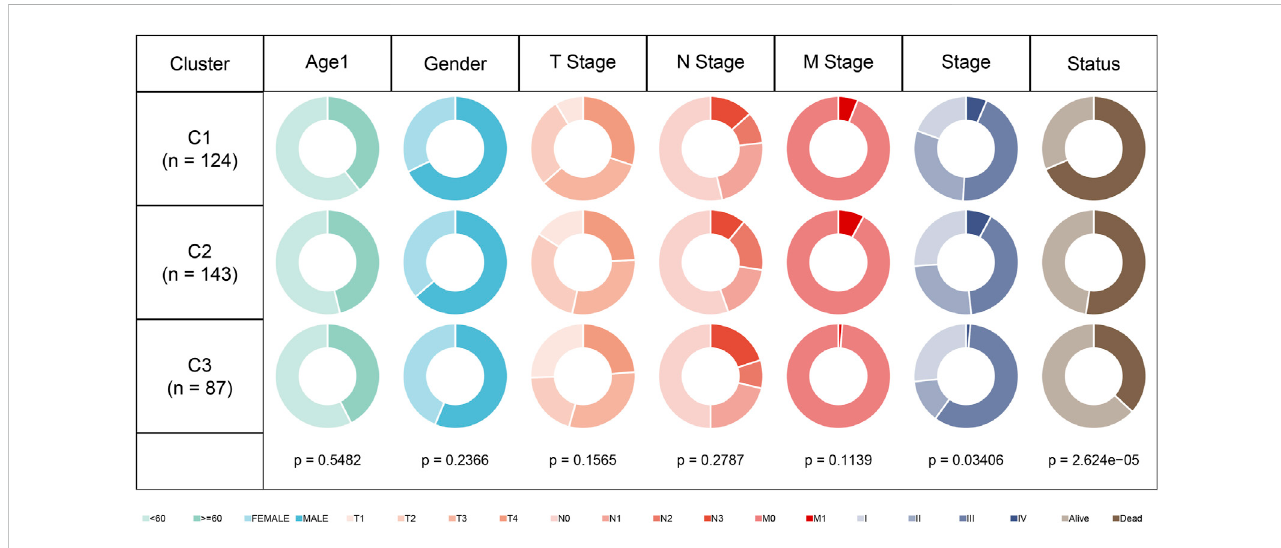
FIGURE 3 Clinical information distribution of three molecular subtypes in the TCGA